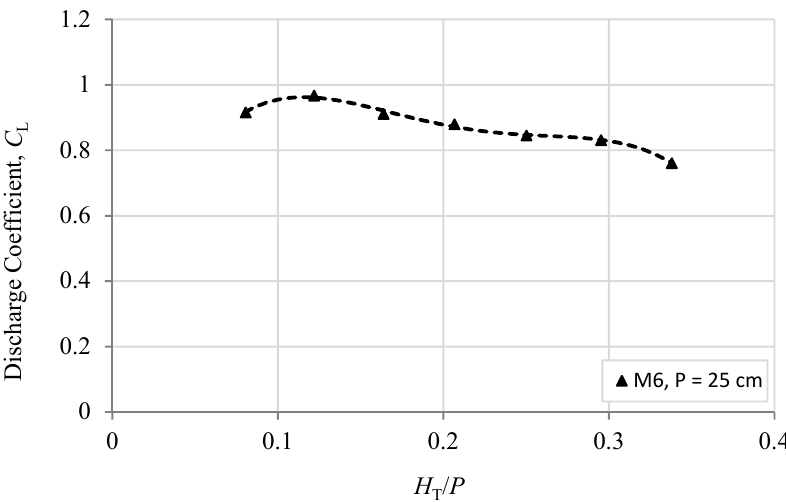
Figure 10. Variations in the discharge coefficient, C L , as a function of the H T /P ratio for the M6 model.